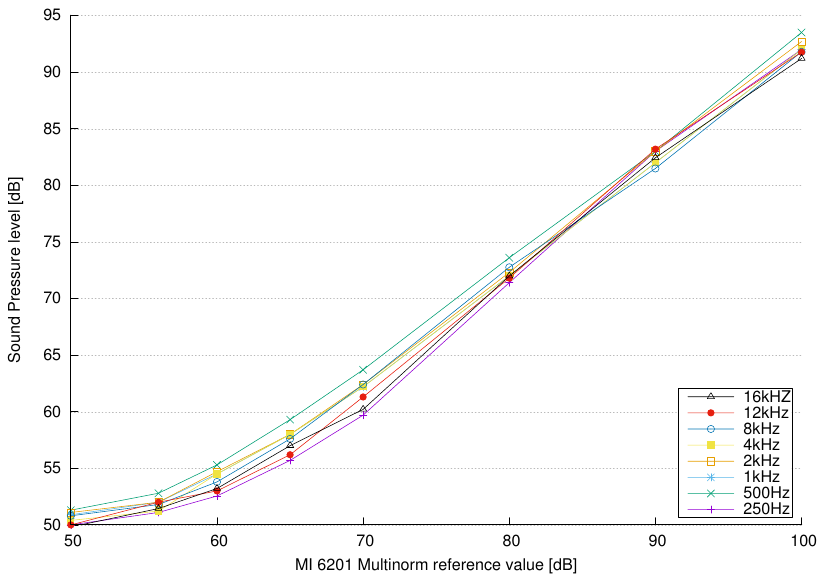
Figure 10. The results for various frequencies of sine waves obtained by the sensor. The horizontal axis represents the sound pressure levels obtained with the MI 6201 MULTINORM sound